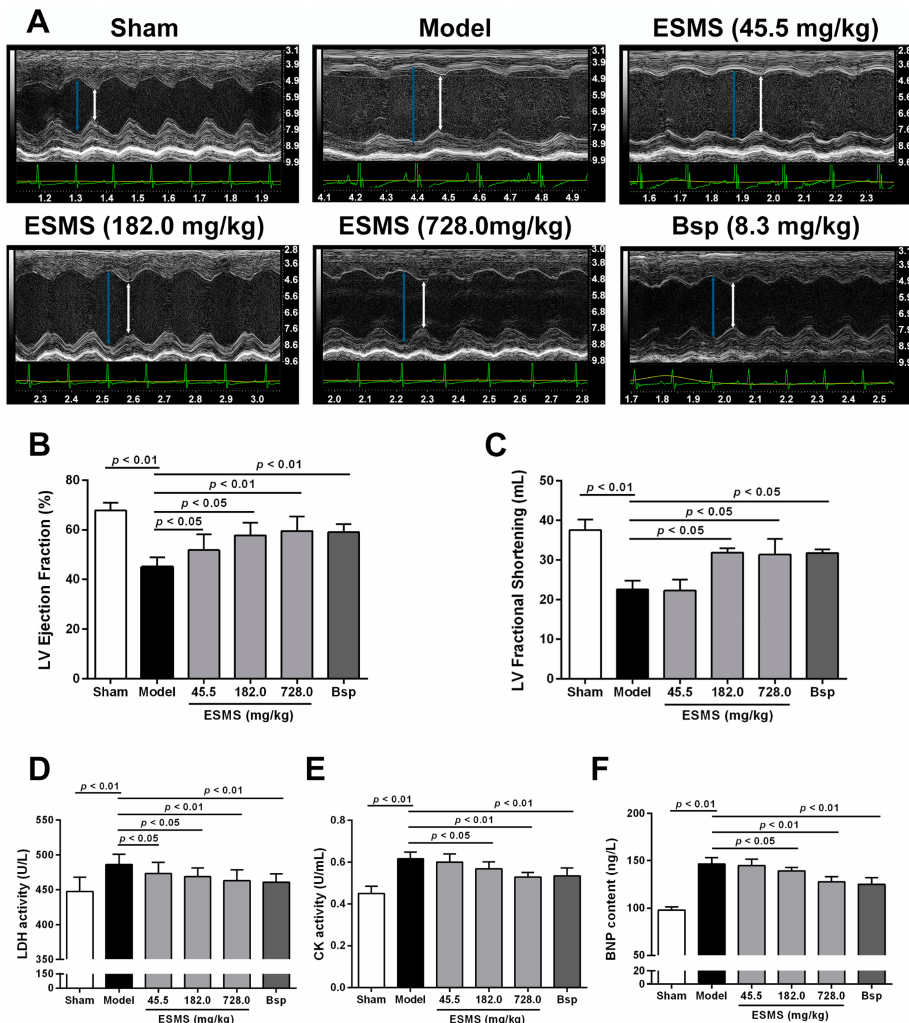
Figure 1. Extract of Sheng-Mai-San (ESMS) ameliorated cardiac function and decreased myocardial injury in myocardial ischemia (MI)-induced heart failure (HF) mice. ( A ) Representative M-mode of echocardiograms. Cardiac performance was determined by echocardiography after three weeks of coronary artery ligation (CAL) in mice. The green peaks show the real-time change in the heart rate of the mouse; the yellow peaks indicate the real-time change of the body temperature; the long blue arrow indicates cardiac diastole; and the short white arrow shows cardiac systole; ( B ) Left ventricular (LV) ejection fraction changes; ( C ) LV fractional shortening changes; ( D ) The release of: lactate dehydrogenase (LDH), ( E ) creatine kinase (CK), ( F ) brain natriuretic peptide (BNP) were determined in serum after three weeks of CAL in mice ( n = 8). Results were presented as mean ± SD. Bsp = Bisoprolol (positive